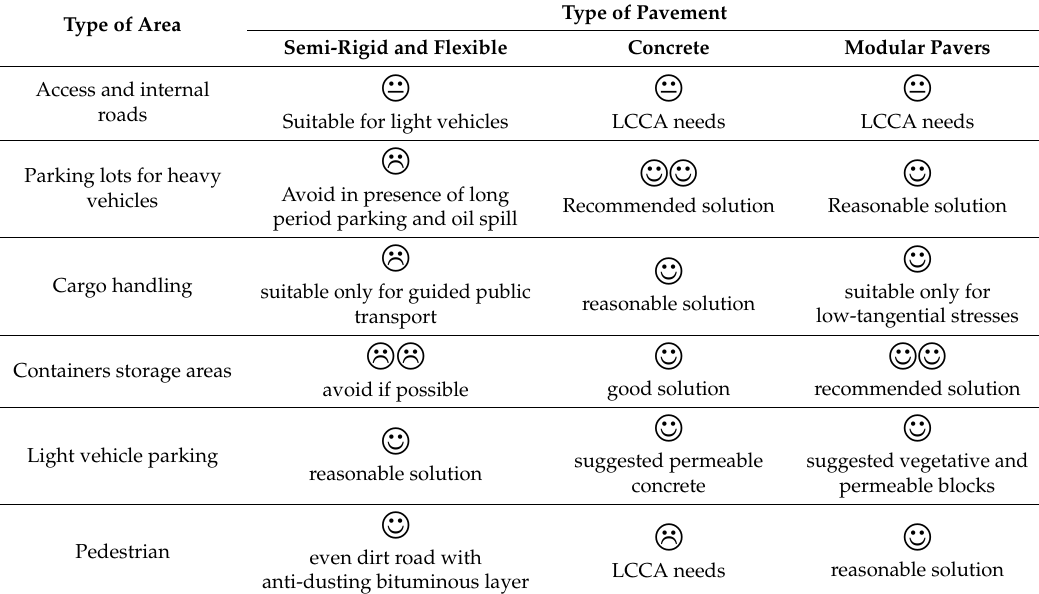
Table 1. Suitability of pavements for different areas considering cost-effectiveness and performance.